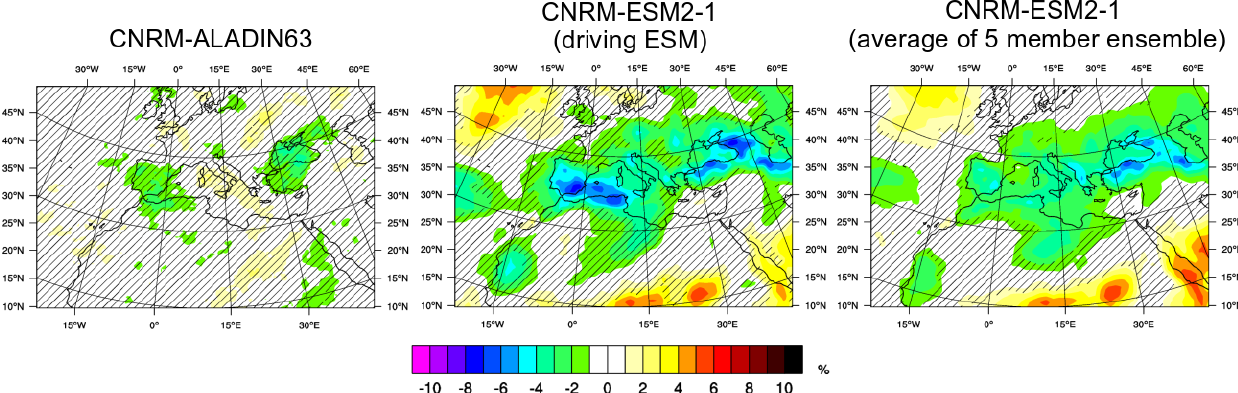
Figure A4. Mean difference for the months of June, July and August between SSP585 and SSP585cst simulations over the period 2021–2050 for cloud cover (%) with the CNRM-ALADIN63 model and its driving ESM. The hatched areas are statically non-significant with a threshold of